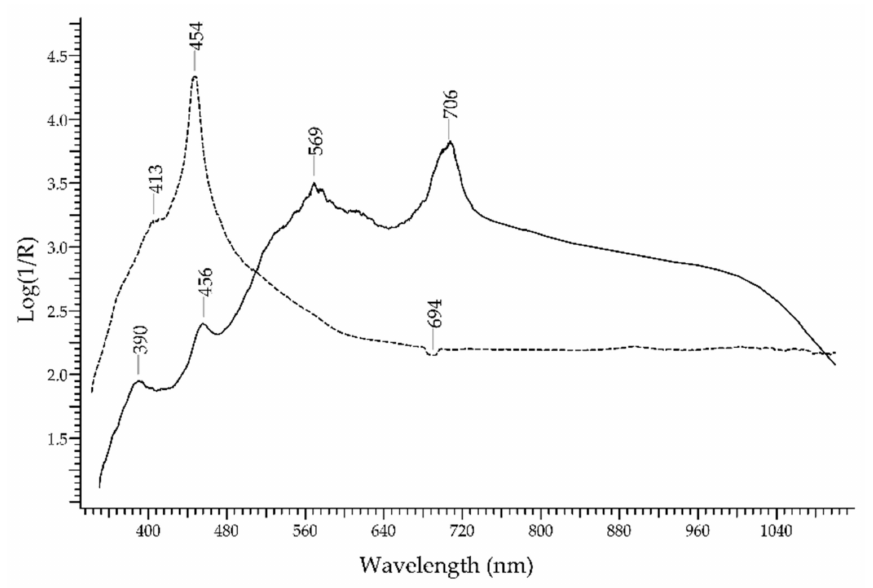
Figure 2. FORS spectrum in reflectance coordinates of a blue sapphire from Cambodia (solid line) and a yellow synthetic sapphire (dashed line).